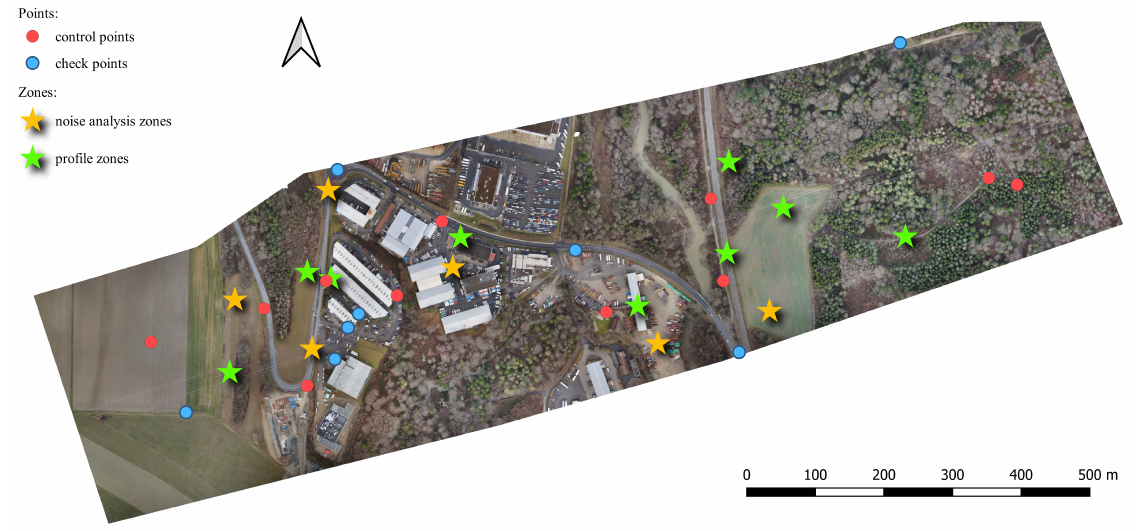
Figure 3: Experimental site near Aclens (Switzerland). The area presents a varied scene with construction, fields, forest and infrastruc- ture (road, rail, power